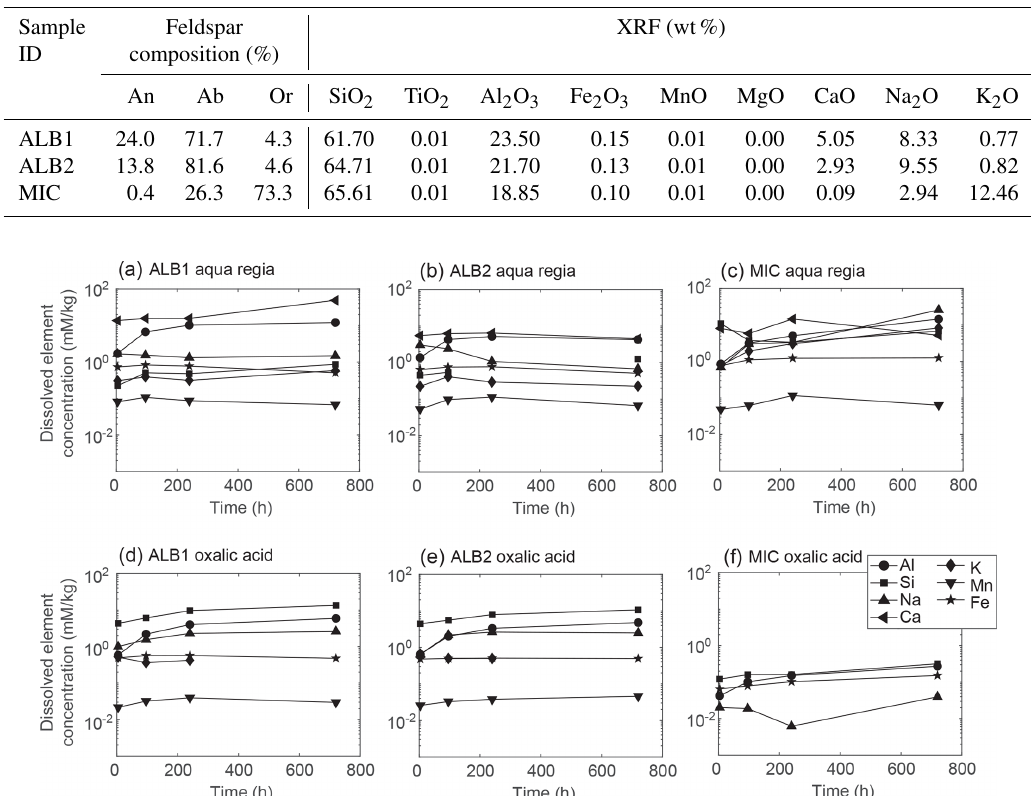
Figure 1. Extracted elements from samples ALB1, ALB2, and MIC using aqua regia (a, b, c) as well as oxalic acid (d, e, f) solutions in the time intervals